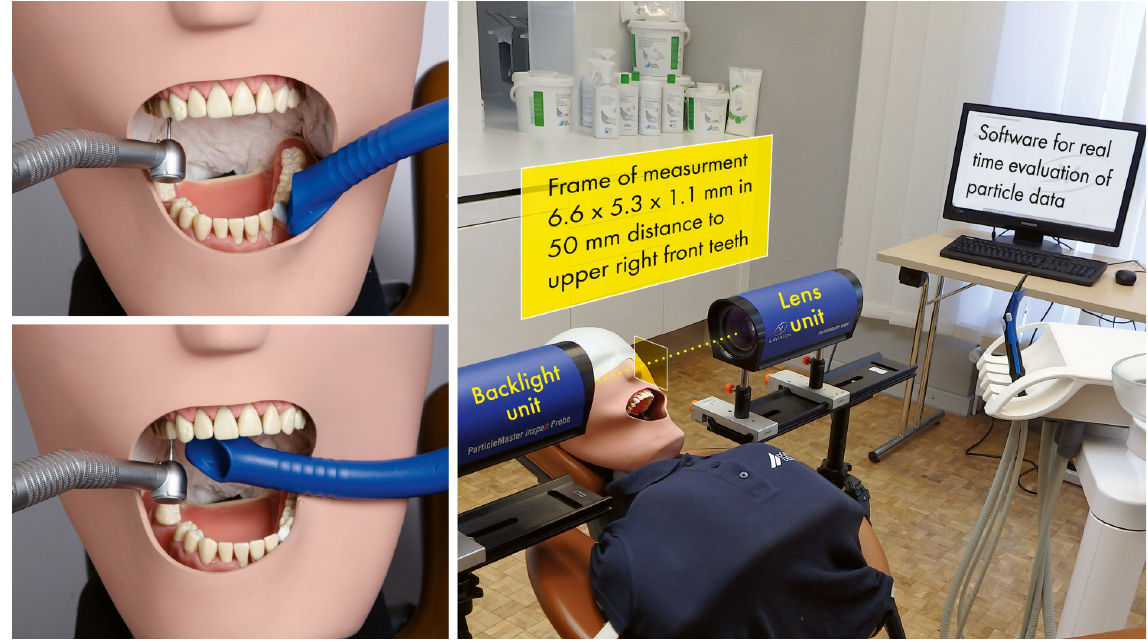
Fig 1. Overview of the experimental setup. Shown on the right side is the overview of the experimental setup with the imaging process technique (ParticleMaster, Lavision, Go¨ttingen, Germany). As shown on left side, a dental turbine (Super-Torque LUX 3 650 B, Kavo, Biberach, Germany) was used for tooth preparation of the first right upper premolar, and a 16 mm sized suction cannula (Universal Cannula, DU¨RR DENTAL SE, Bietigheim-Bissingen, Germany) was utilized in a suboptimal position in the opposite jaw (upper left side) and an optimal position (approximately 10 mm from the tooth (lower left side). The experimental setup was the same for all three types of cannulas. Dental turbines and cannulas were held in place by tripods during the